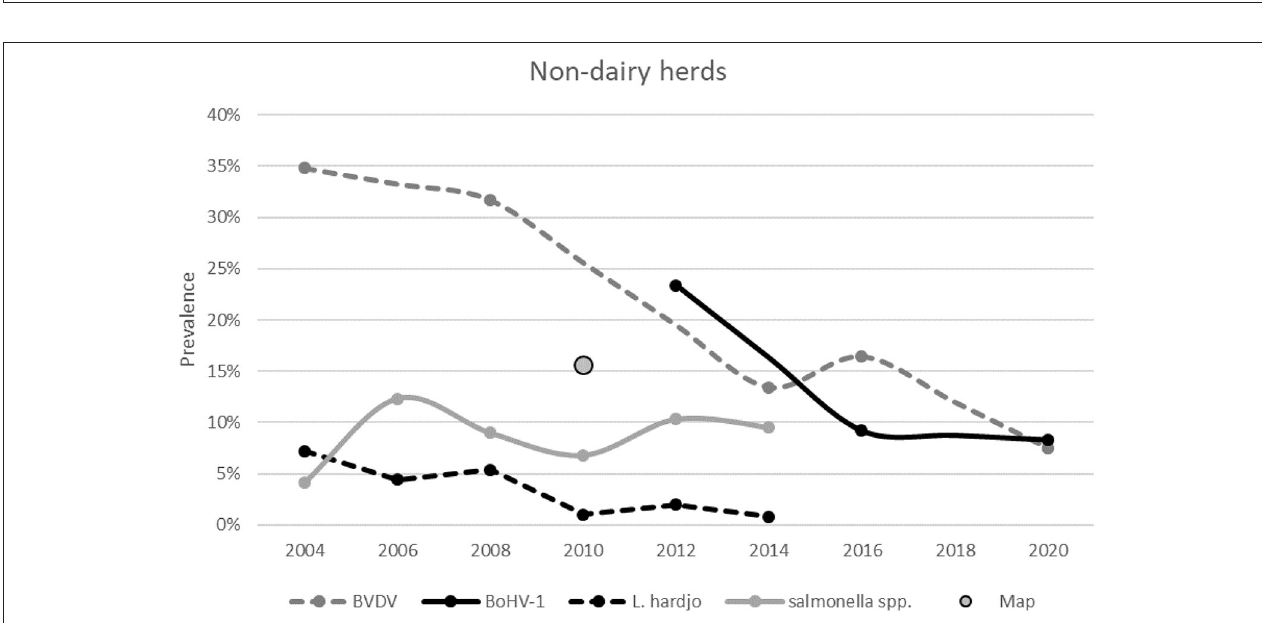
FIGURE 12 | The herd prevalence from surveys conducted for BVDV, BoHV-1, Salmonella spp. and Map between 2004 and 2019 at Dutch non-dairy herds. The accompanying confidence intervals are presented in Appendix 2 .